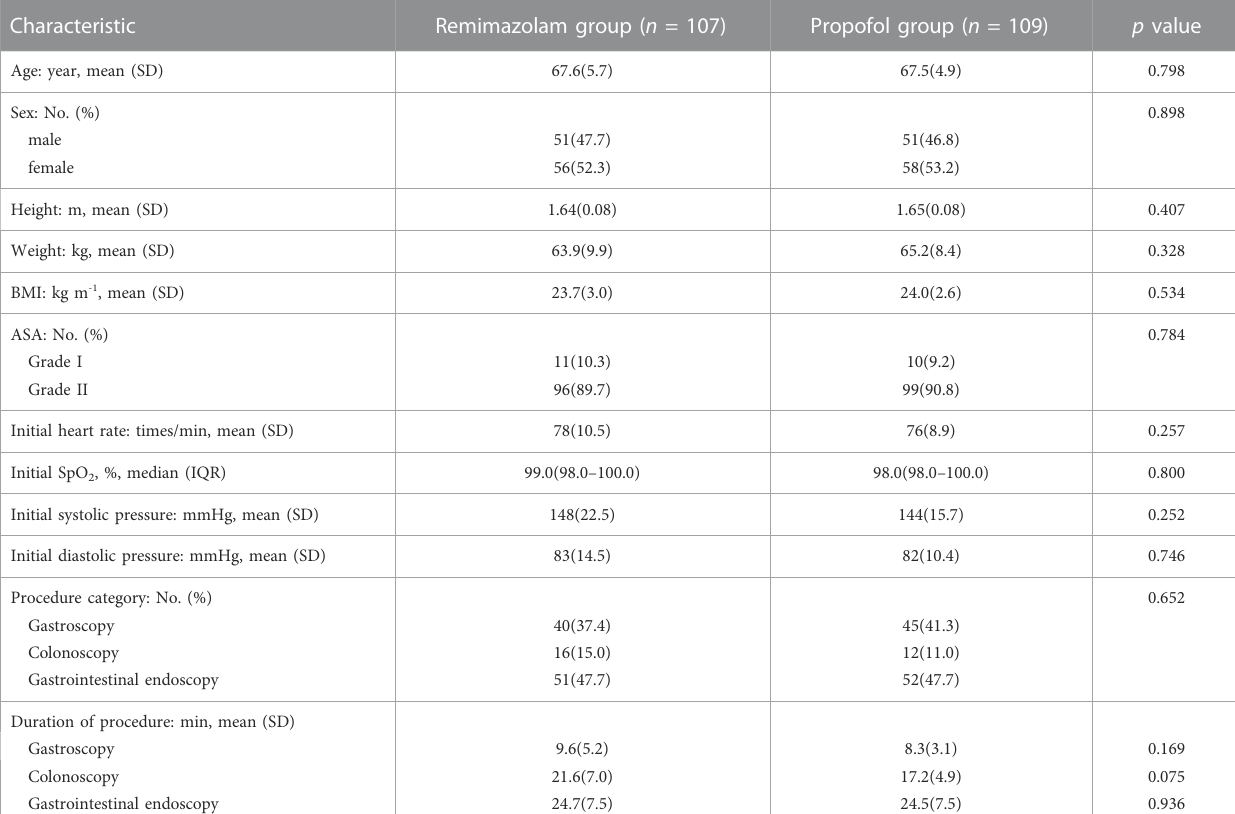
TABLE 1 Baseline characteristics of the patients and procedure.